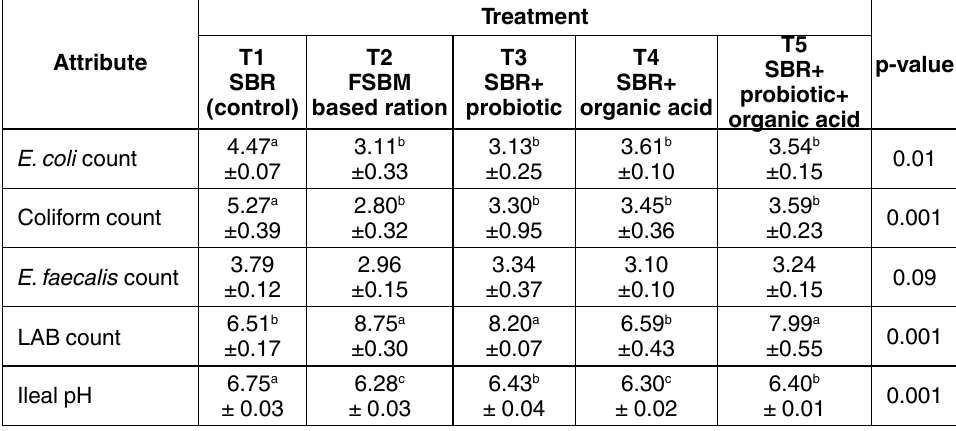
CFU/ml) and pH of 10